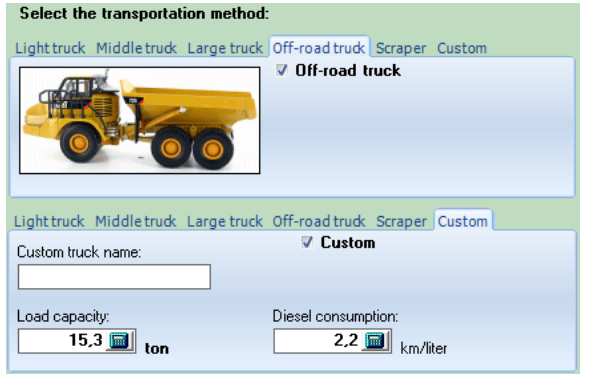
Figure 3. Transportation method